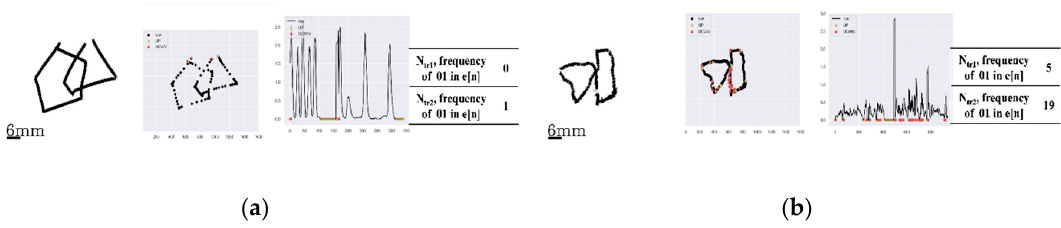
Figure 7. Two examples for detection of tremors: ( a ) The case without a detectable tremor, where the numbers of the ‘up’ events followed by ‘down’ events in the recorded touch-events were 0 and 1 for the left and right-portion figures, respectively (both < 5). ( b ) The case with detectable tremors where the numbers of the ‘up’ events followed by ‘down’ events in the recorded touch-events were 5 and 19 for the left and right-portion figures, respectively (one was > 5).